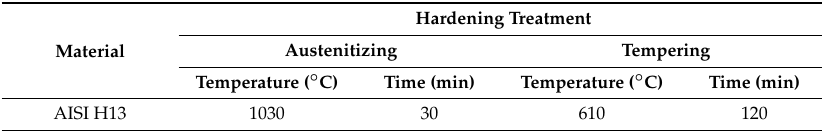
Table 2. Heat treatment of AISI H13.